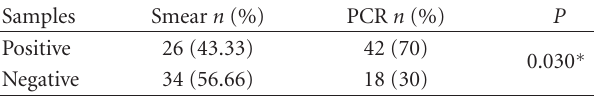
Table 3: Comparison of PCR and smear methods for detection of mycobacterial infections.